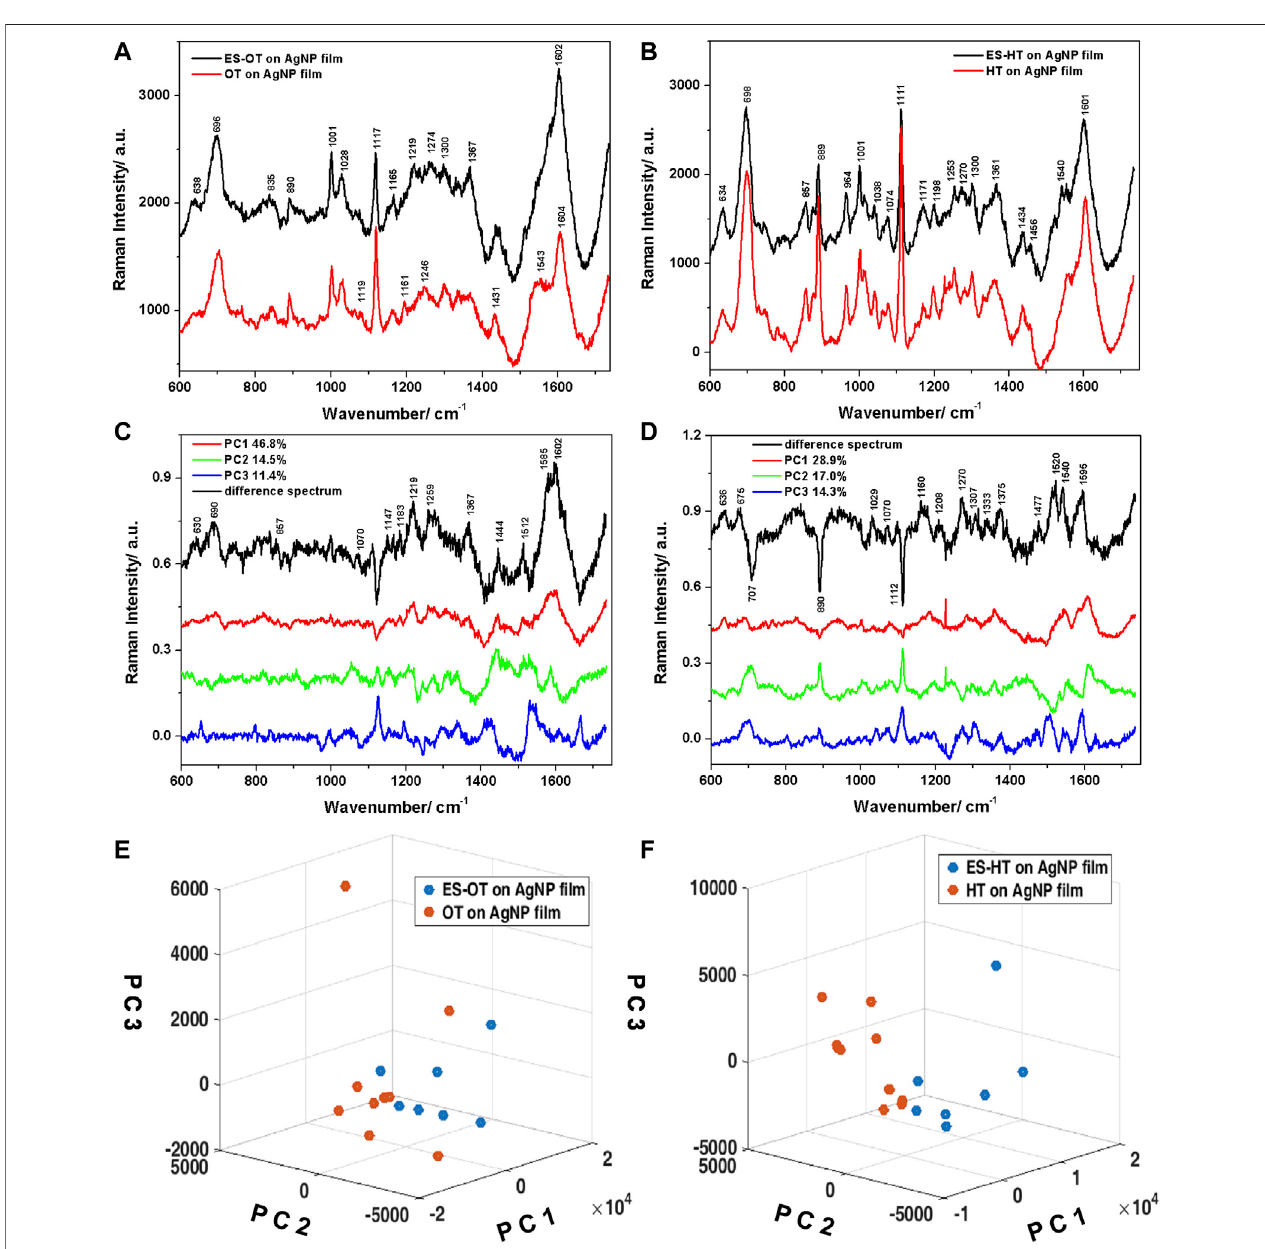
FIGURE 9| (A) Average Raman spectra plotted together withpositive standard deviations characteristic tothe ES-OT, respectively OT on Ag NPs fi lms. (B) Same as (A) , for ES-HT, respectively HTon AgNPs fi lms. (C,D) Loadings of the fi rst three PCsand the calculated difference spectra correspondingto the OT, respectively the HT ligands. (E,F) Three-dimensional scatter plots showing the differentiation of the two groups of spectra for the OT, respectively the HT case.